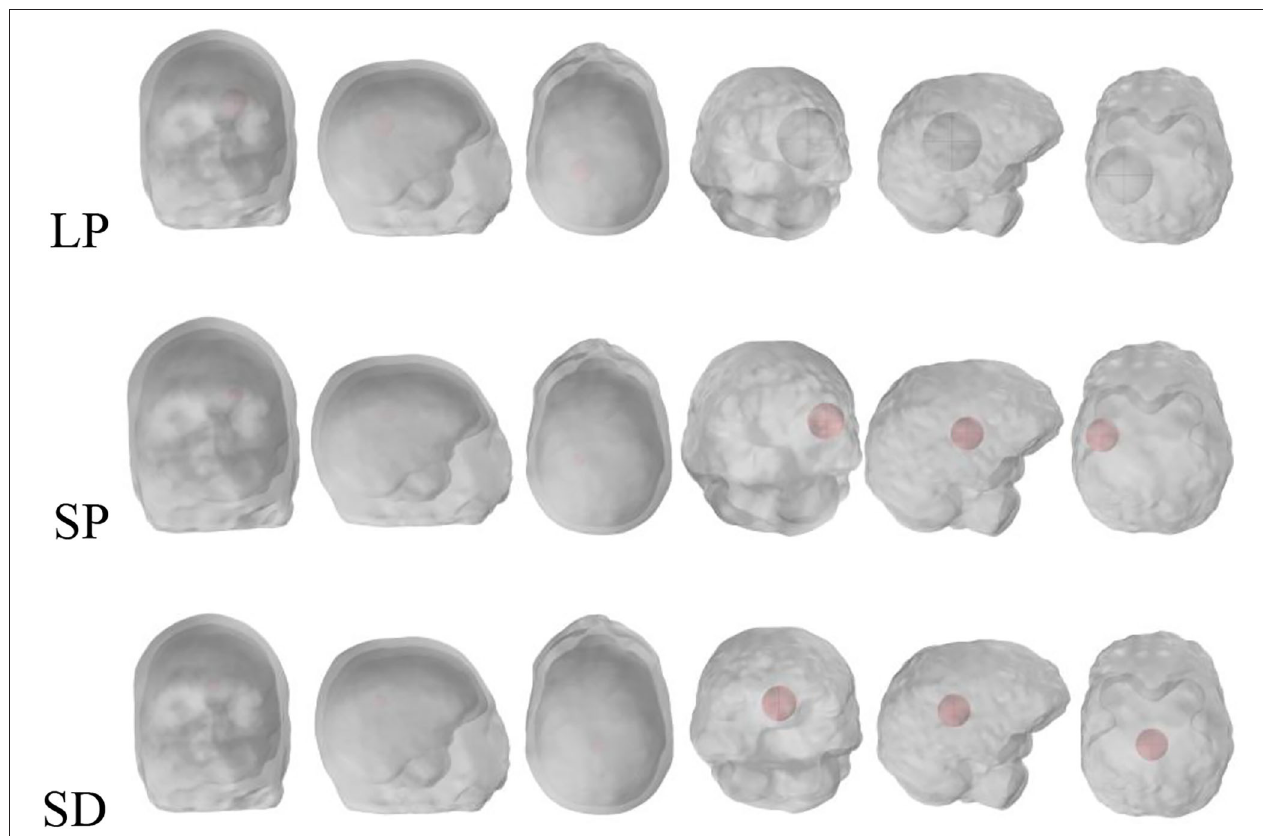
FIGURE 2 | Stroke regions in the left hemisphere of the brain (red), with three different cases: LP, SP and